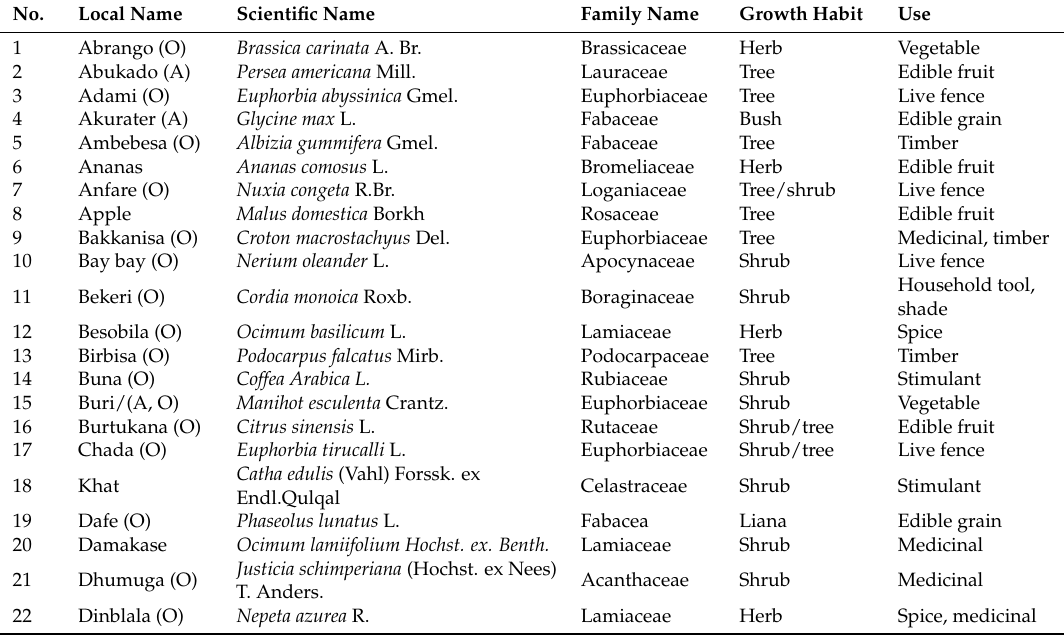
Table A1. Plant species identified in Yayo and Hurumu